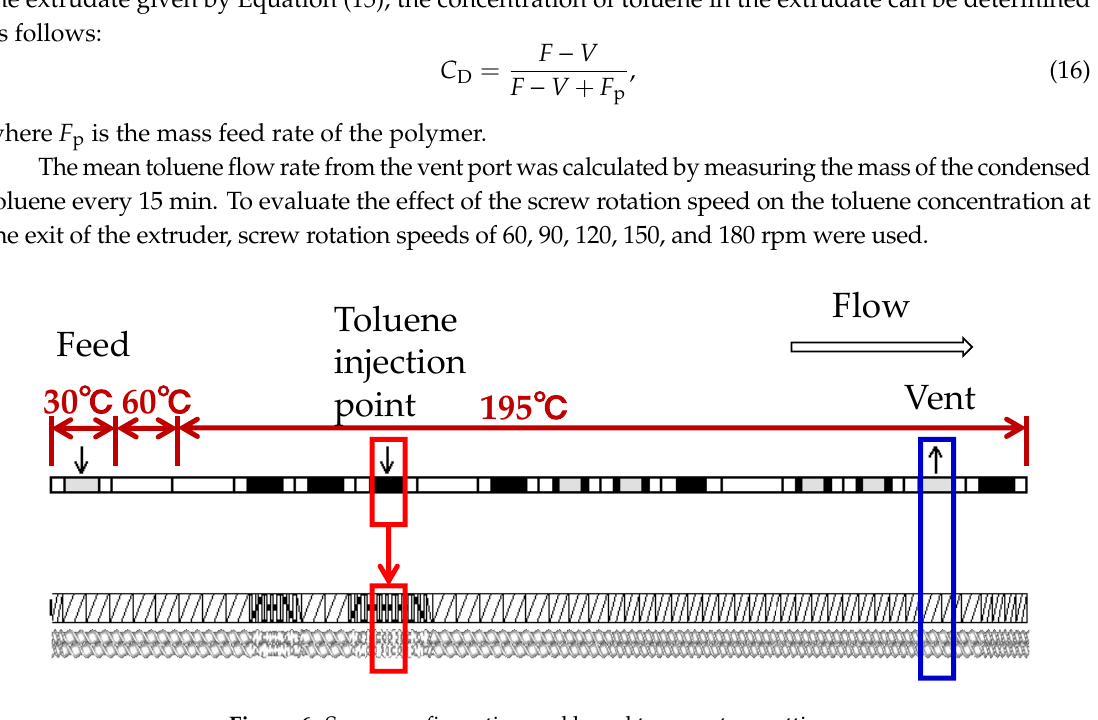
Figure 6. Screw configuration and barrel temperature settings.